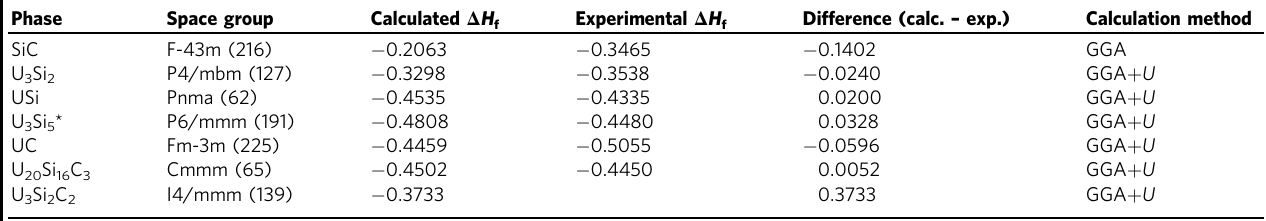
Table 3 Corrected formation energies of the studied